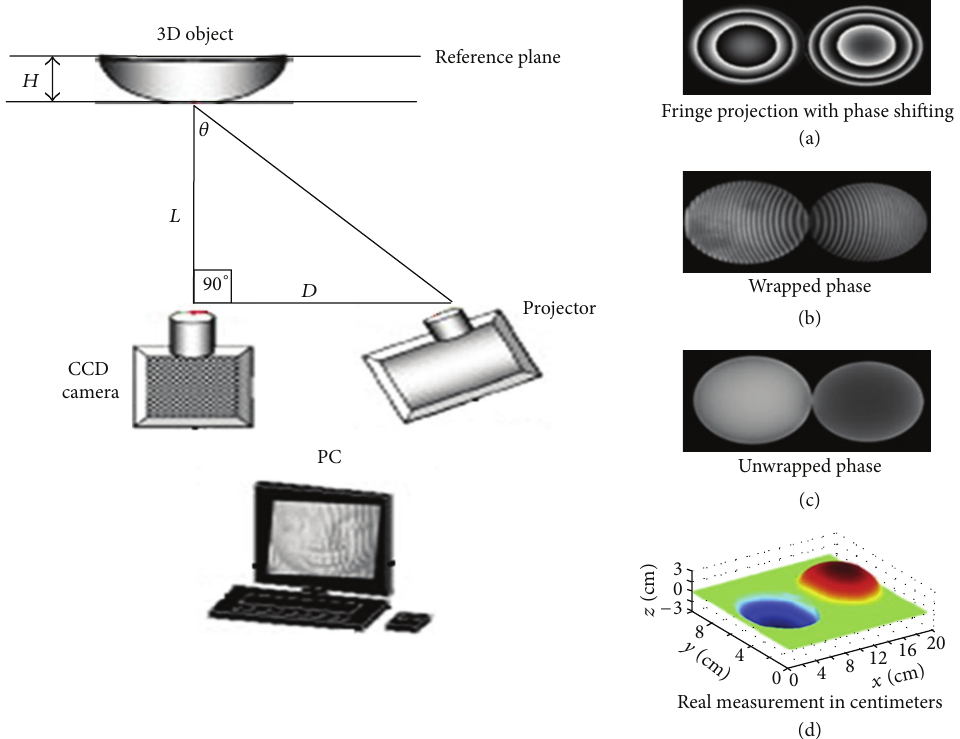
Figure 8: Process of the tridimensional digitizing technique using structured light.